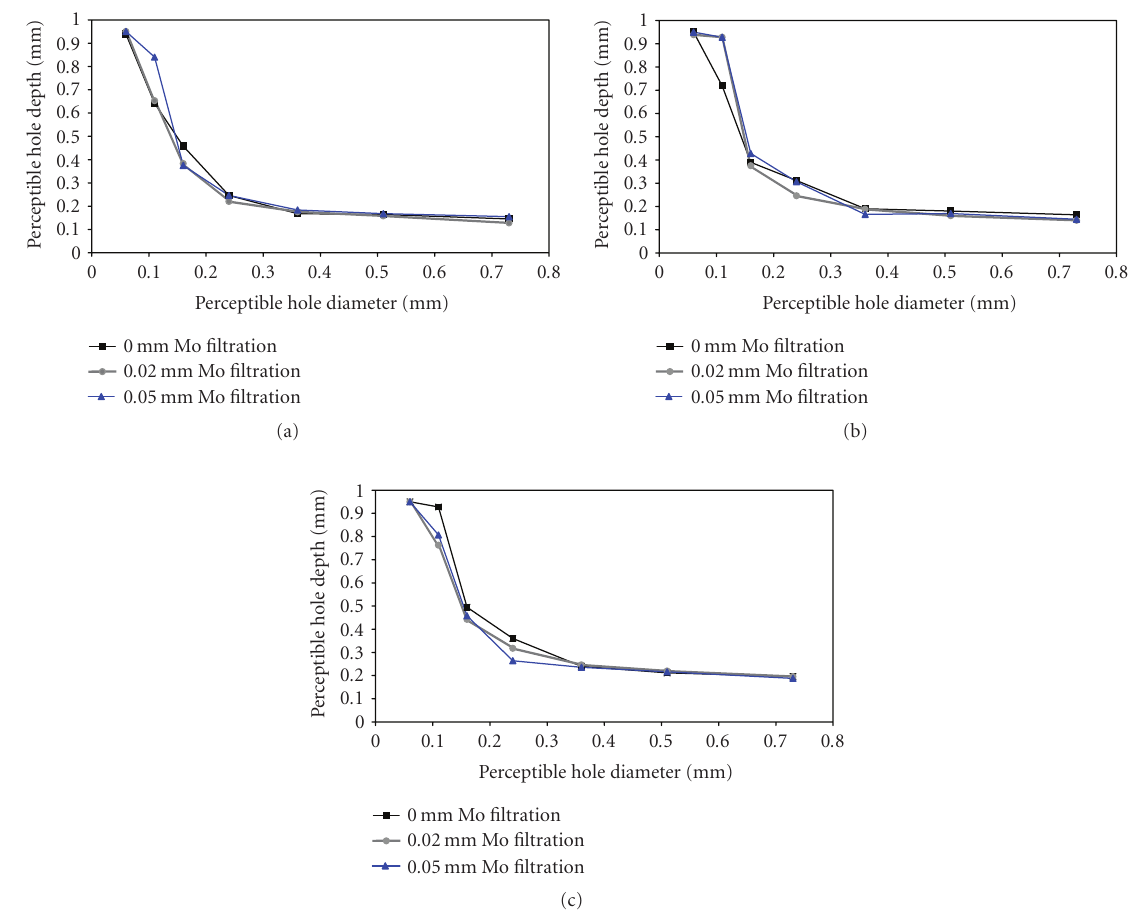
Figure 6: (a) Contrast-detail curves using the 2 . 15 cm phantom under the exposure of 22 kVp with a 0 . 0cm (curve with squares), 0 . 02 cm (curve with circles), and 0 . 05 cm (curve with triangles) Mo filter. (b) Contrast-detail curves using the 2 . 15 cm phantom under the exposure of 28 kVp with a 0 . 0cm (curve with squares), 0 . 02 cm (curve with circles), and 0 . 05 cm (curve with triangles) Mo filter. (c) Contrast-detail curves using the 2 . 15 cm phantom under the exposure of 35 kVp with a 0 . 0cm (curve with squares), 0 . 02 cm (curve with circles), and 0 . 05 cm (curve with triangles) Mo